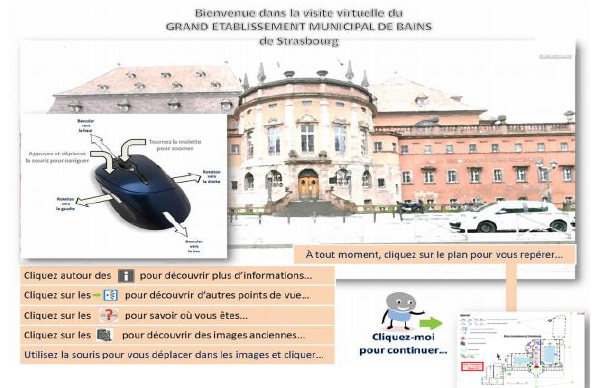
Figure 10: Avatar for the path of the guided tour.